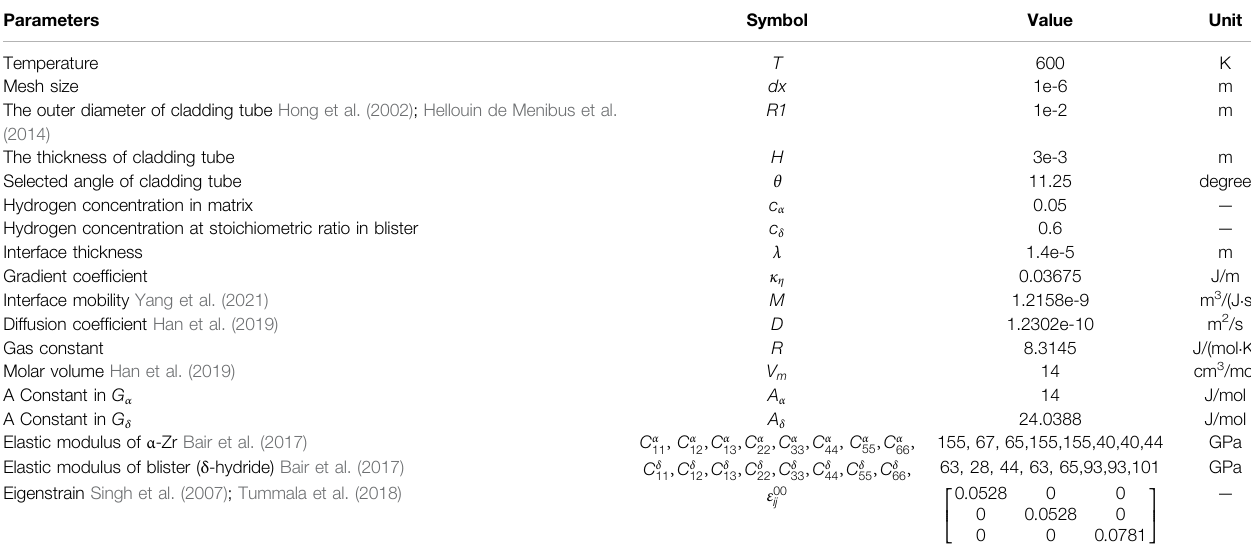
TABLE 1 | Model parameters and conditions used in the simulations.